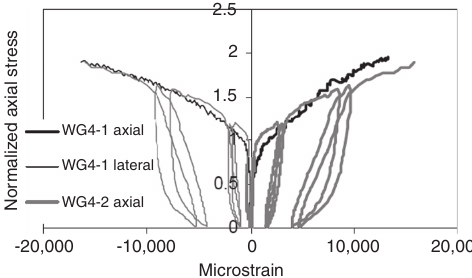
Figure 2 Stress-strain curves for WC3 specimens.